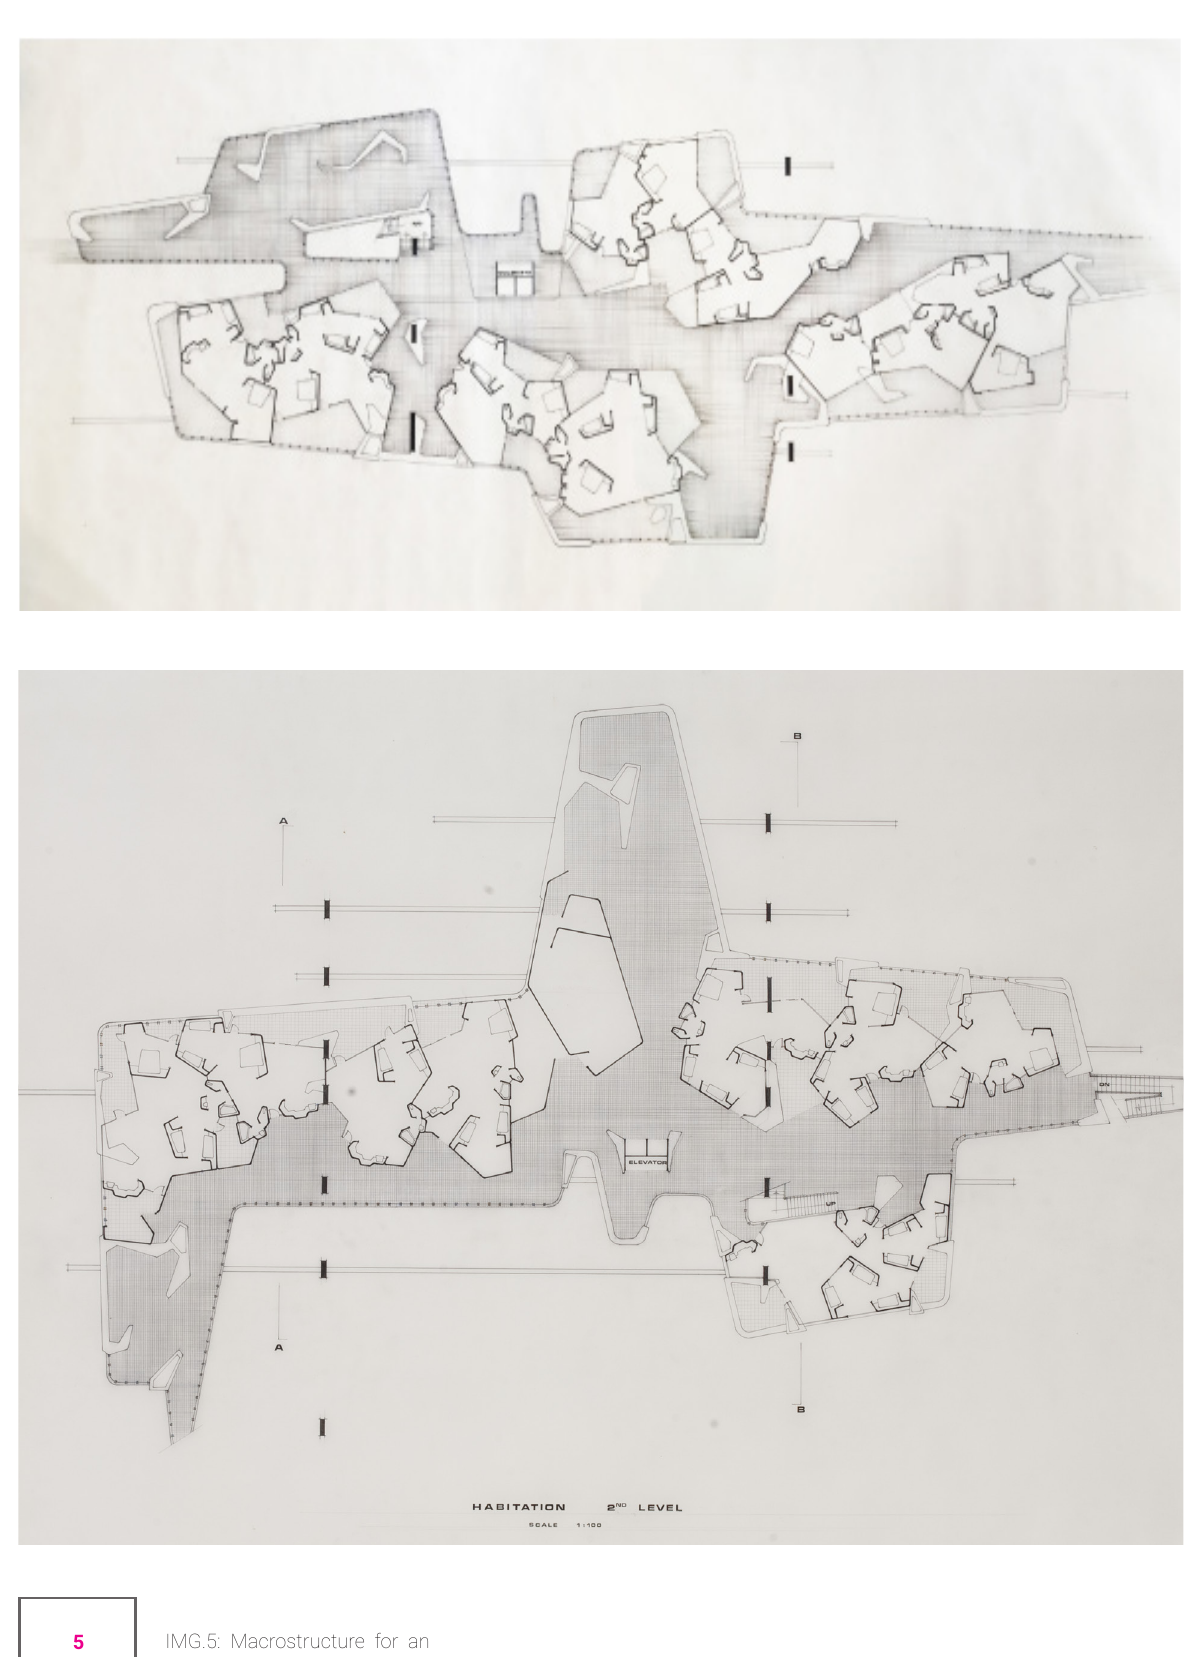
IMG.6: Macrostructure for